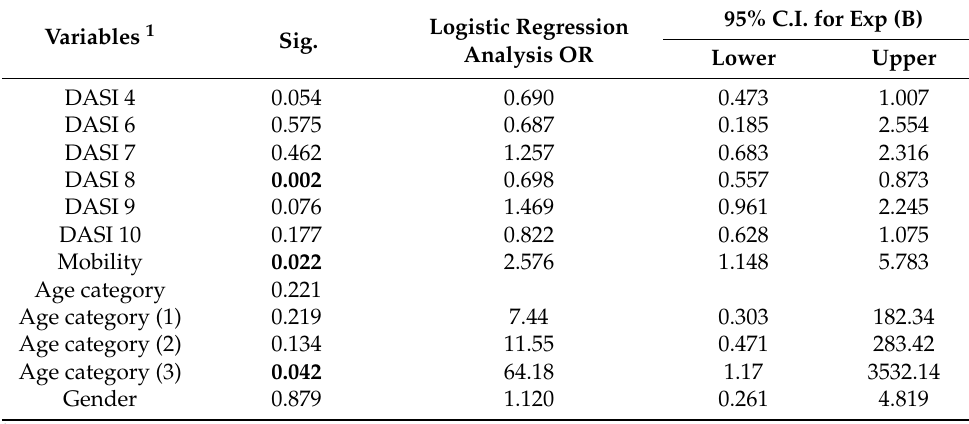
Table 6. Results of predictors for frailty in the middle-aged CVD group. Variables 1